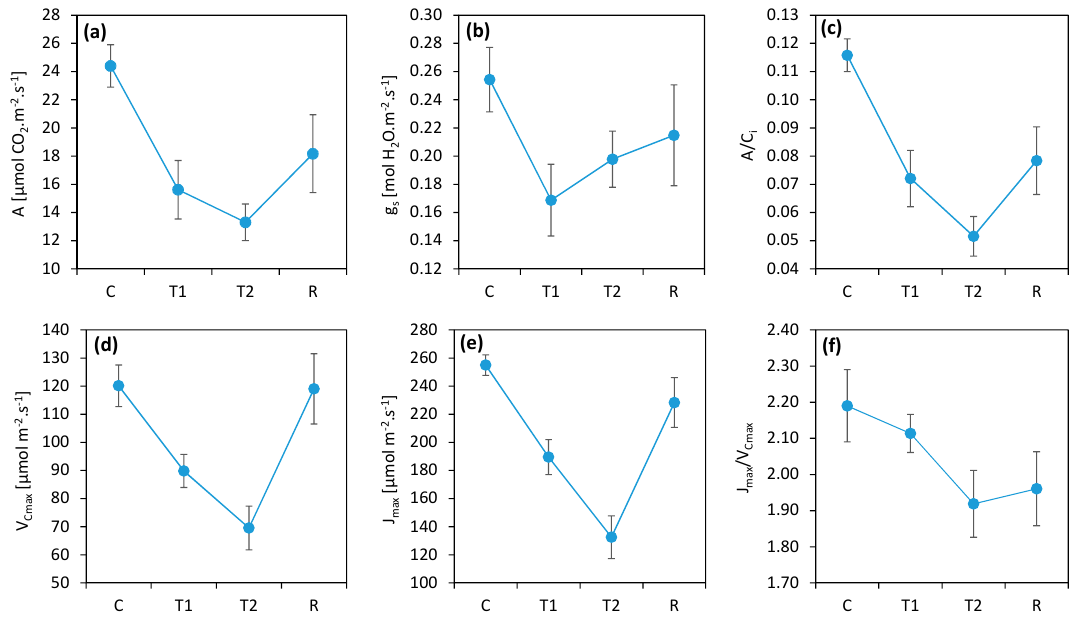
Figure 1. Heat effects on the parameters derived from the gas exchange measurements ( a ) A: photosynthesis rate; ( b ) g s : stomatal conductance; ( c ) C i : internal CO 2 concentration; ( d ) V Cmax : maximum carboxylation rate; ( e ) J max : maximum electron transport velocity; ( f ) J max / V Cmax ratio. C: control; T1: thermal effect in the first phase; T2: thermal effect in the second phase; R: recovery phase. The points represent the mean values for all measured wheat plants of all genotypes. The error bars represent the standard error of the means.